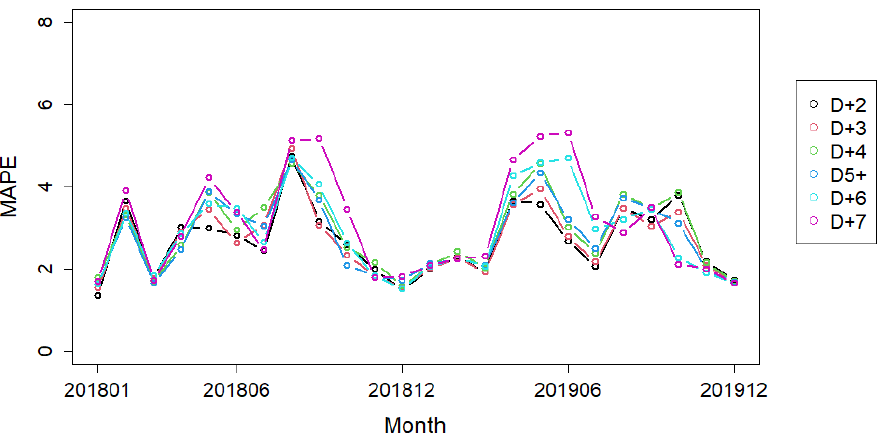
Figure 10. The Model Performance of Monthly MAPEs on the Days ( D + 2) to ( D + 7), for the RNN Model.